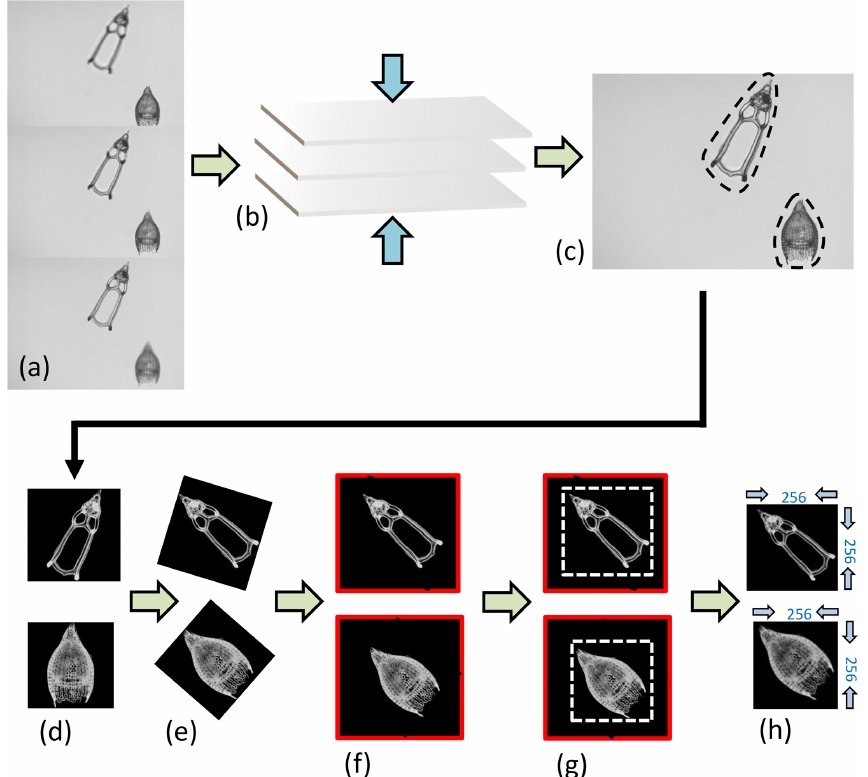
Figure 3. Image processing. (a) Three “raw” images taken from the microscope from the same FOV but from different focal points, which are (b) stacked together using the Helicon Focus 7 software (c) to produce one entire focused and crisp image in which each particle in one FOV is segmented into an individual image or so called vignette. (d) The segmented images are also transformed into a square 8-bit grayscale with a black background and white objects that are (e) further processed in Python by first rotating the radiolarian objects in the vignettes with a 45 ◦ angle so that the longest axis goes from the upper left corner to the lower right corner. (f) The vignettes are then filled again into squares so that no parts of the specimens are removed. (g) Thereafter, they are cut again into squares just precisely so that the specimen fills the entire square and, lastly, the new images are resized to 256 pixels on each side image (h)